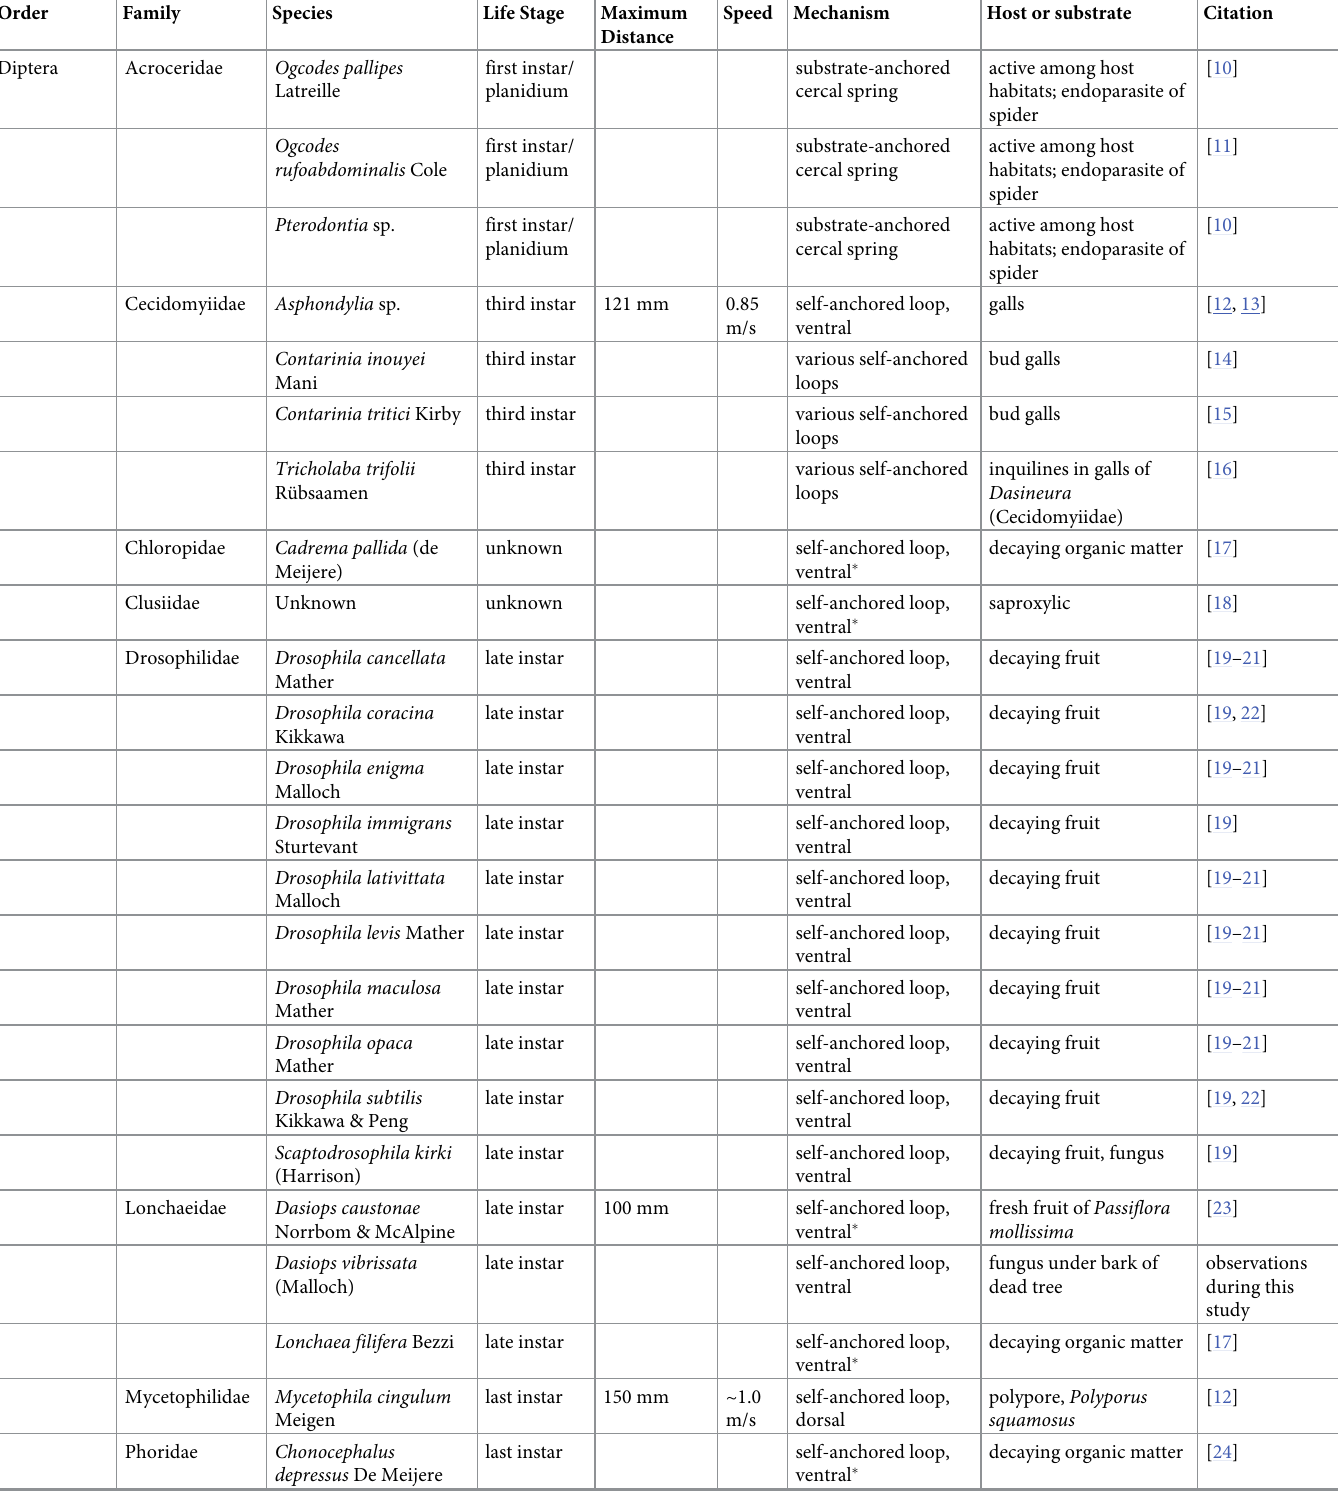
Table 1. Taxonomic distribution of jumping behavior among insect